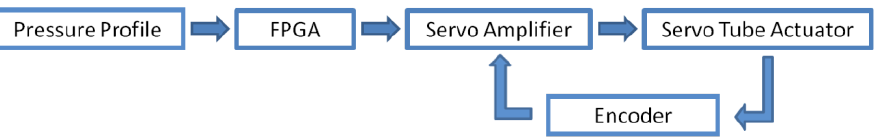
Figure 4. Block diagram of semi-closed-loop servo-tube injector.